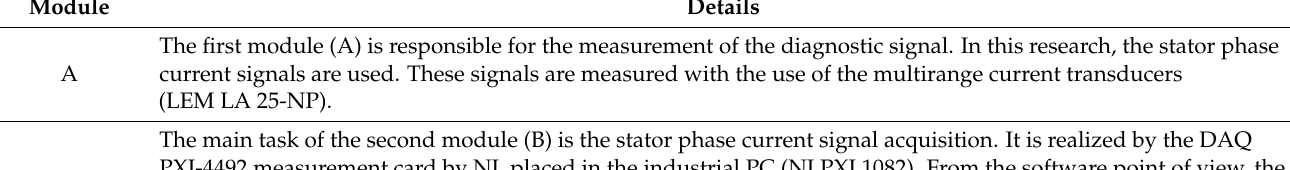
Table 5. The details of the intelligent diagnosis system modules.